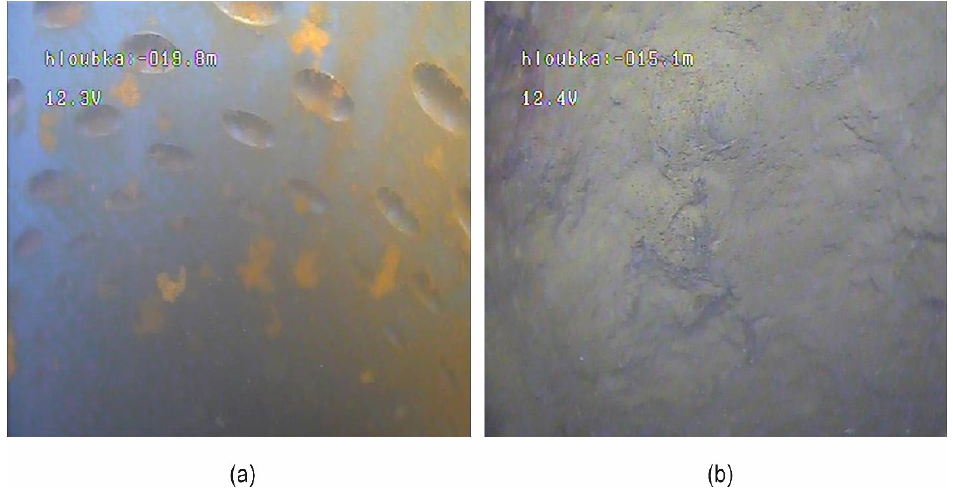
Figure 14. Camera pictures of the well casing: ( a ) HJ-4 extraction well, depth 19.8 m b.g.l.; ( b ) HJ-3 extraction well, depth 15.1 m b.g.l.